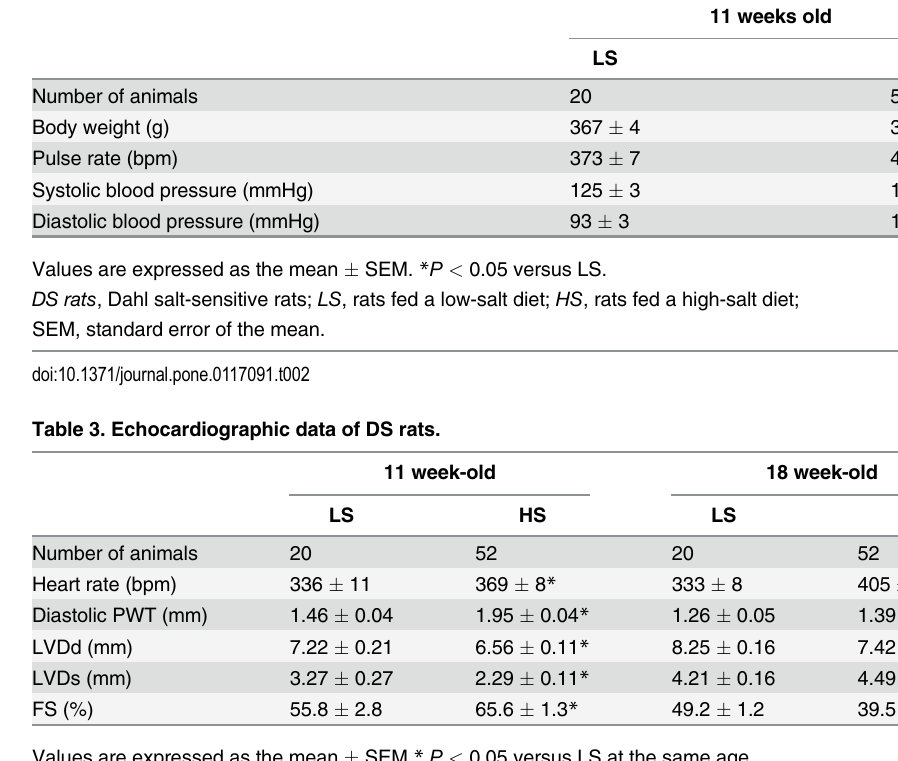
Table 4. Postmortem analysis of Dahl rats at 18 weeks old. LS HS 45 min 6 h 45 min 6 h Number of animals 10 10 26 26 Body weight (g) 431 (cid:1) 8 433 (cid:1) 5 377 (cid:1) 5 * 380 (cid:1) 5 * Heart weight (g) 1.12 (cid:1) 0.03 1.11 (cid:1) 0.02 1.48 (cid:1) 0.02 * 1.46 (cid:1) 0.02 * Heart weight/Body weight (g/kg) 2.60 (cid:1) 0.04 Liver weight (g) 12.30 (cid:1) 0.13 * Liver weight/Body weight (g/kg) 24.8 (cid:1) 0.41 24.04 (cid:1) 0.30 31.64 (cid:1) 0.31 * 32.38 (cid:1) 0.25 * Values are expressed as the mean (cid:1) SEM. * P < 0.05 versus LS at the same time settings. LS, rats fed a low-salt diet; HS, rats fed a high-salt diet;